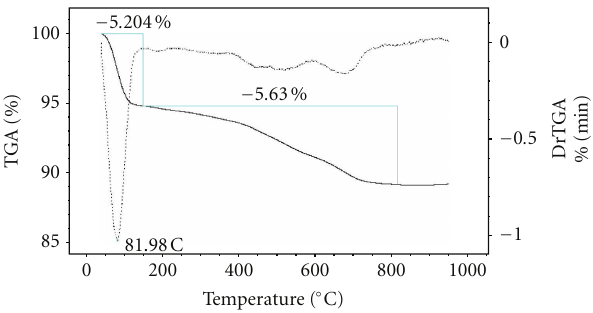
Figure 5: TGA curves of a Maghnite-Na + obtained in nitrogen atmosphere at heating rate of 10 ◦